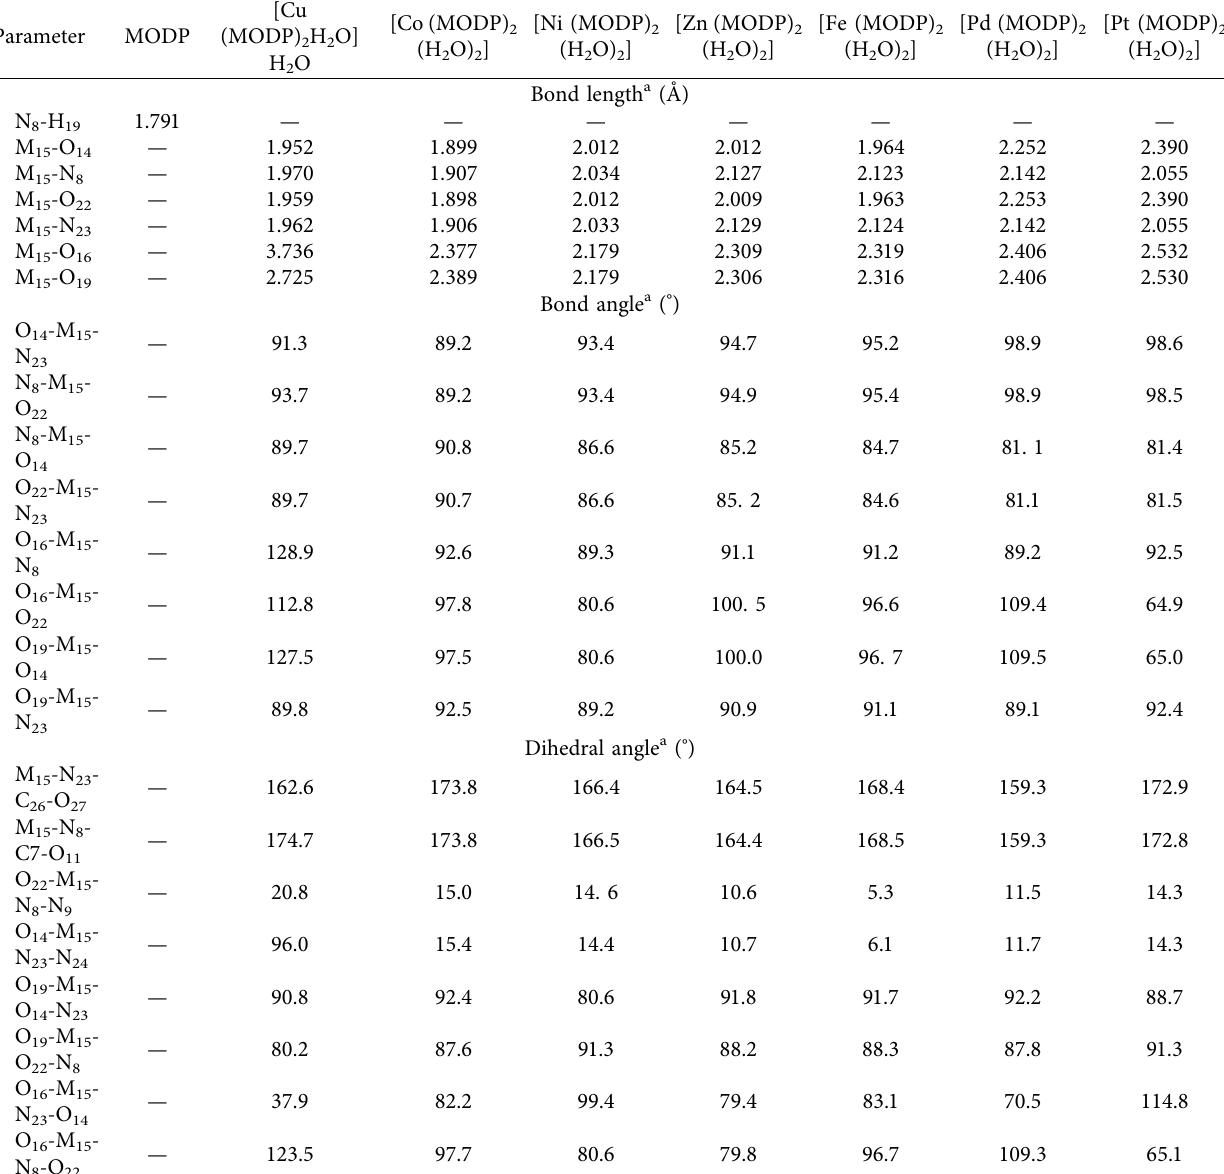
Table 3: Selected bond lengths (˚A), bond angles ( ° ), and dihedral angles ( ° ) of molecules optimized in DFT/B97-3c in the gas phase. Parameter MODP